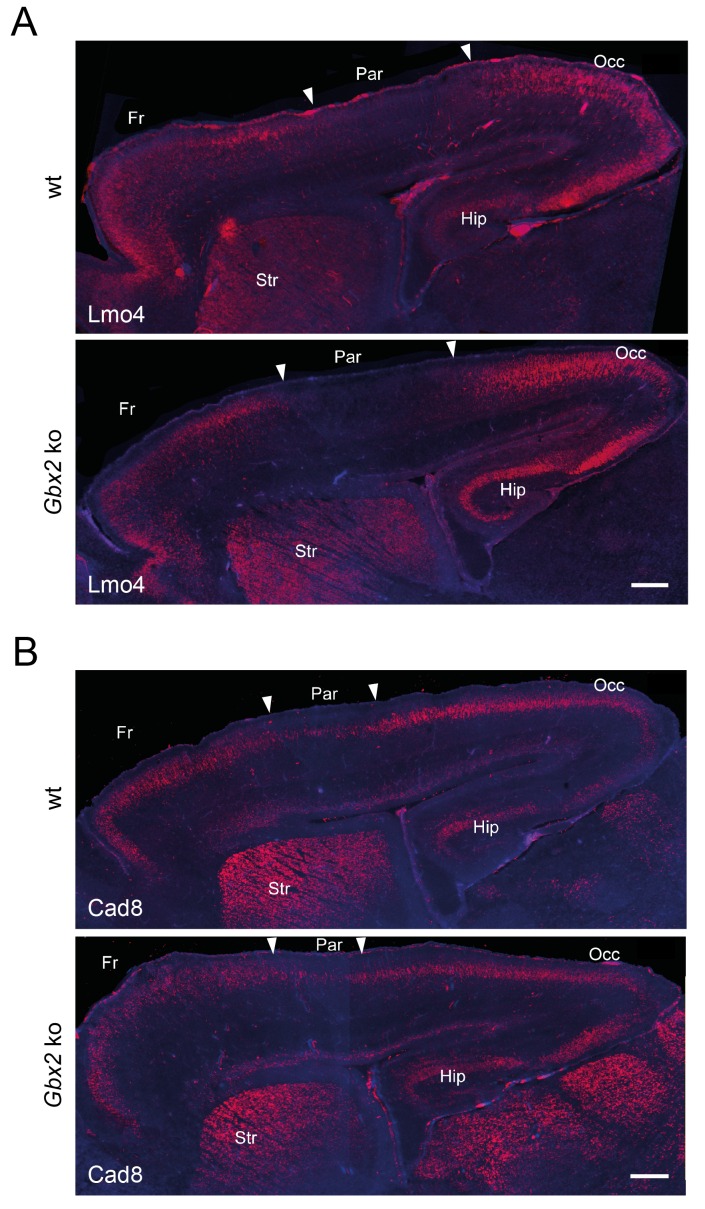
Loss of TCAs in Gbx2 knock-out mice does not affect neocortical arealization.Neocortical arealization (sagittal views) in newborn wild type (wt) and Gbx2 knock-out mice assessed by in situ hybridization for Lmo4 (A) and Cad8 (B). Arrowheads indicate borders between different areas. Fr, frontal cortex; Par, parietal cortex (prospective somatosensory cortex); Occ, occipital cortex (prospective visual cortex); Str, striatum; Hip, hippocampus. Scale bar, 250 µm.